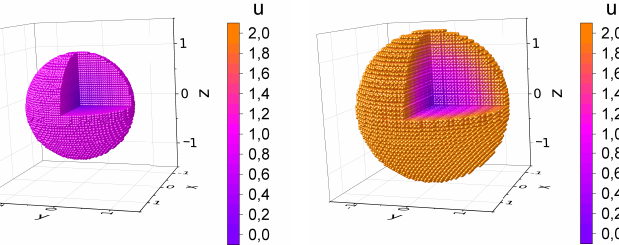
Figure 6. The 3D distribution of dust SPH particles with ε = 0.8 and short relaxation time t stop = 0.001 ( model S) at two time moments t = 0 and t =